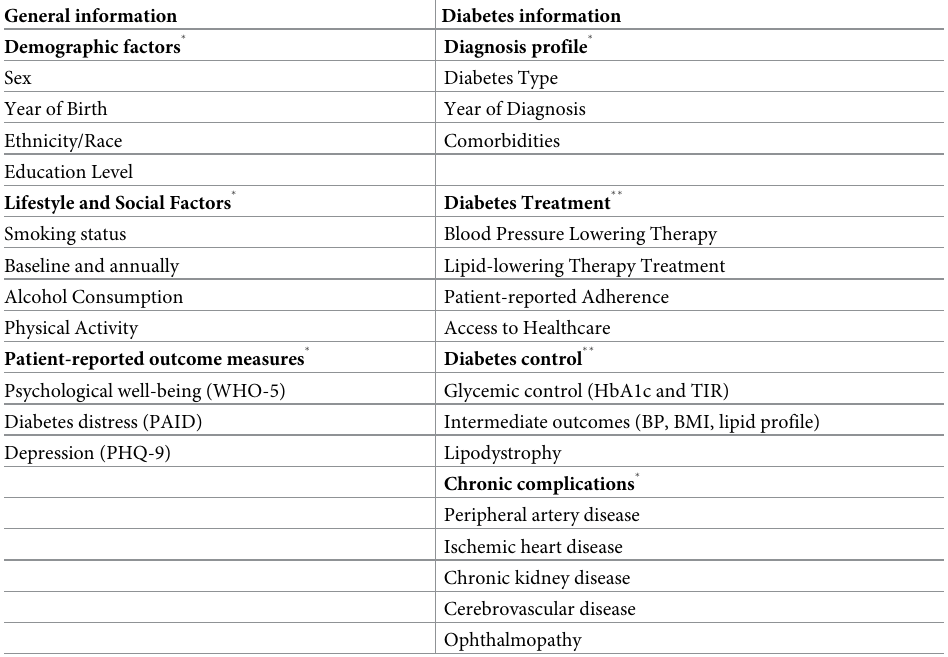
Table 1. Data to be evaluated in the timeline of the Klivo Intervention Program